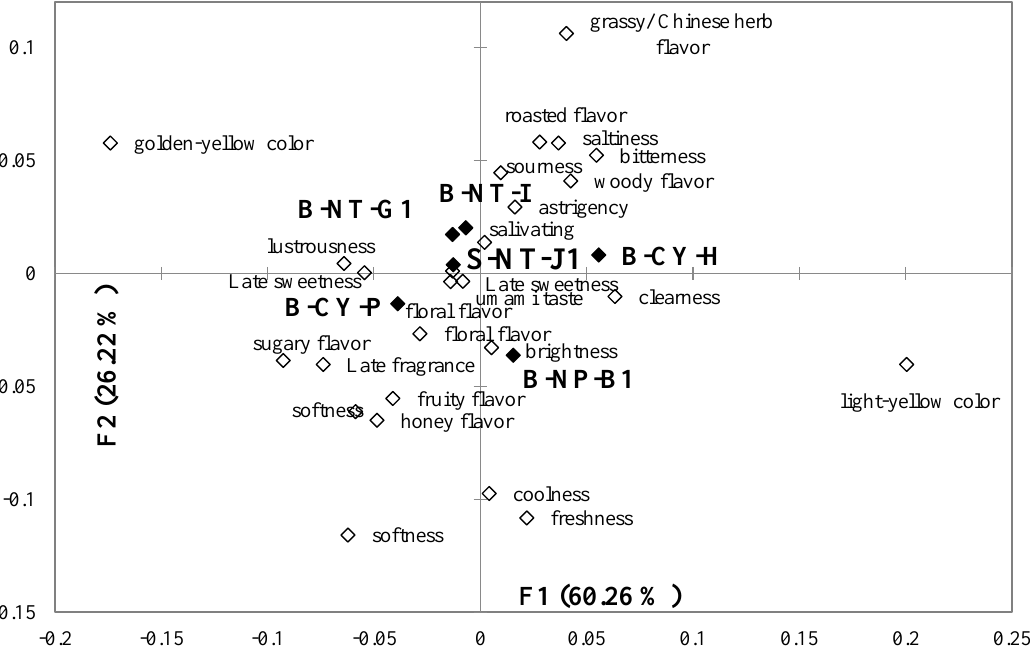
Figure 4. A bi-plot by correspondence analysis for the cold infusions of the first round of Taiwanese GABA Oolong tea made by the TTES #12 in association with the 27 sensory attributes selected by more than 20% of participants. Significant difference ( p < 0.05) of panelists’ selection proportions for each attribute among the seven tea samples were determined by Cochran’s Q test. The pairwise post-hoc McNemar test (Bonferroni) was also performed, and the tea samples signed with different alphabet letters were significantly different in the frequencies of panelists’ selection for the attribute listed in the same row.